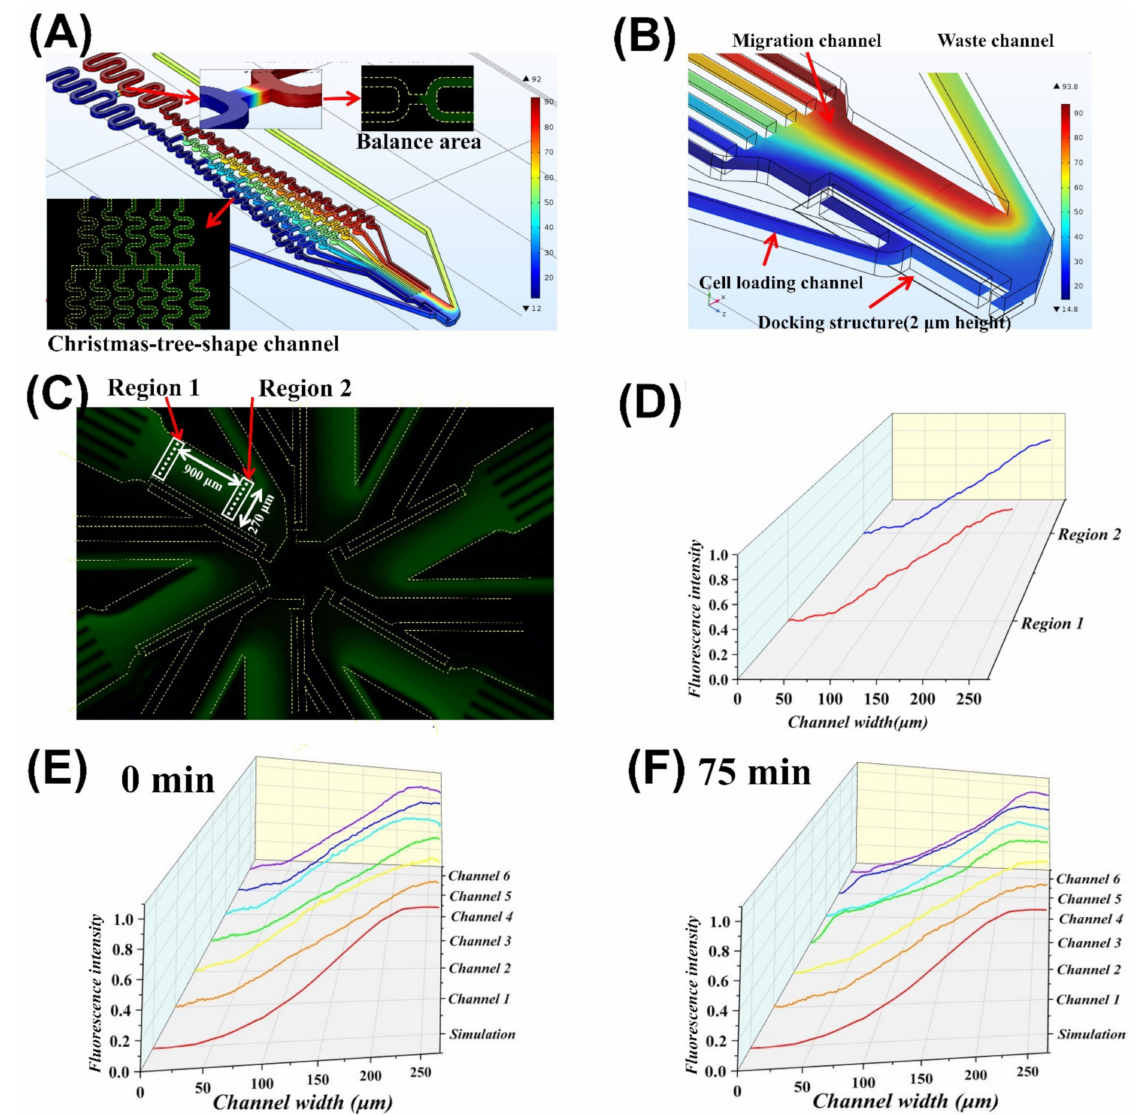
Figure 3. Gradient simulation and test. ( A ) A simulation heat map of an independent unit, including the tested fluorescence images at the balance area and the Christmas-tree-shape channel of the SC 2 chip; ( B ) Enlarged gradient heat map in the migration channel; ( C ) The fluorescent image of the six migration channels through single imaging using the microscope; ( D ) Comparison of the fluorescence gradient curves at two different positions in one migration channel as labeled in ( C ); ( E ) Comparison of the simulative and experimental fluorescent gradient profiles along the migration channel at 0 min; ( F ) Comparison of the simulative and experimental fluorescent gradient profiles along the migration channel at 75